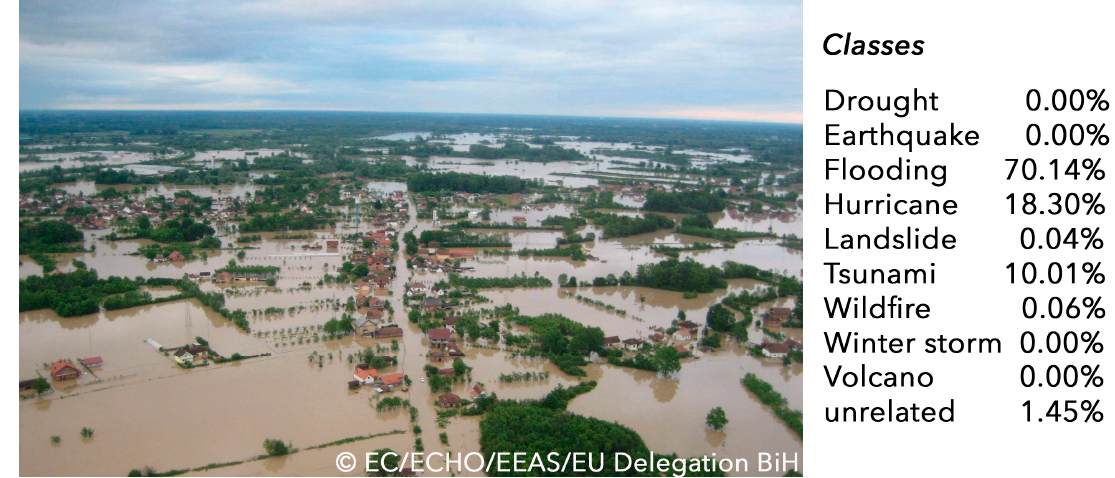
Figure 4. Image Recognition Interpretation Result.